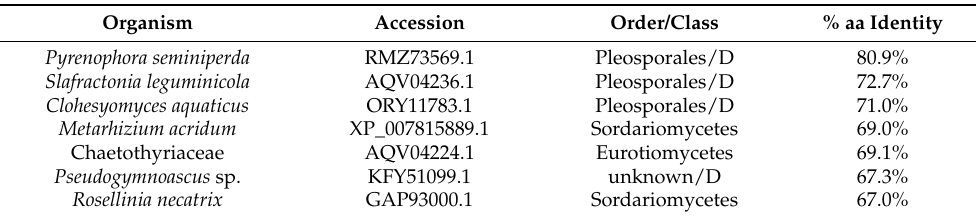
Table 3. Percent amino acid (aa) identity of pblast results of PKS-NRPS 58882 sequence. Fungal order within the class Dothideomycetes (D) or other fungal class as listed.